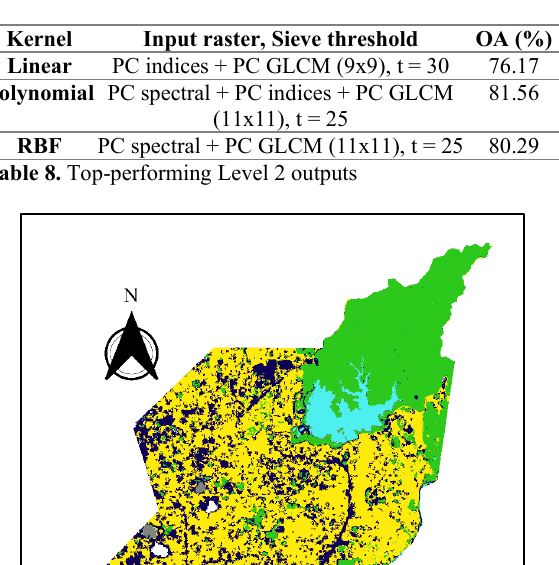
Legend General Land